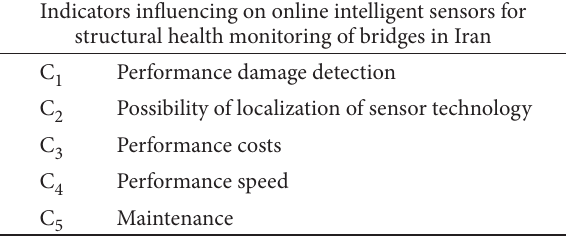
Table 3. Final results of SWARA method in weighting criteria